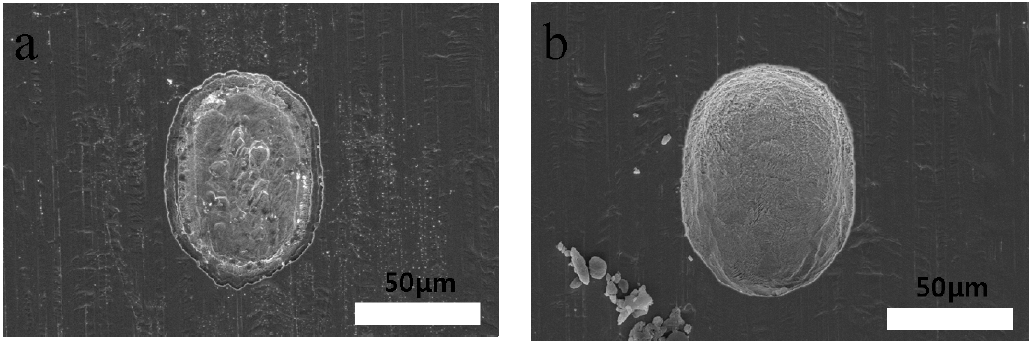
Figure 11. SEM images of Invar film machined surface produced by ( a ) wet etching, ( b ) electrochemical machining.